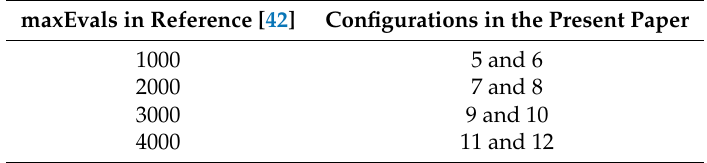
Table 18. Correspondence between [42] and the present paper on algorithm parameter settings.